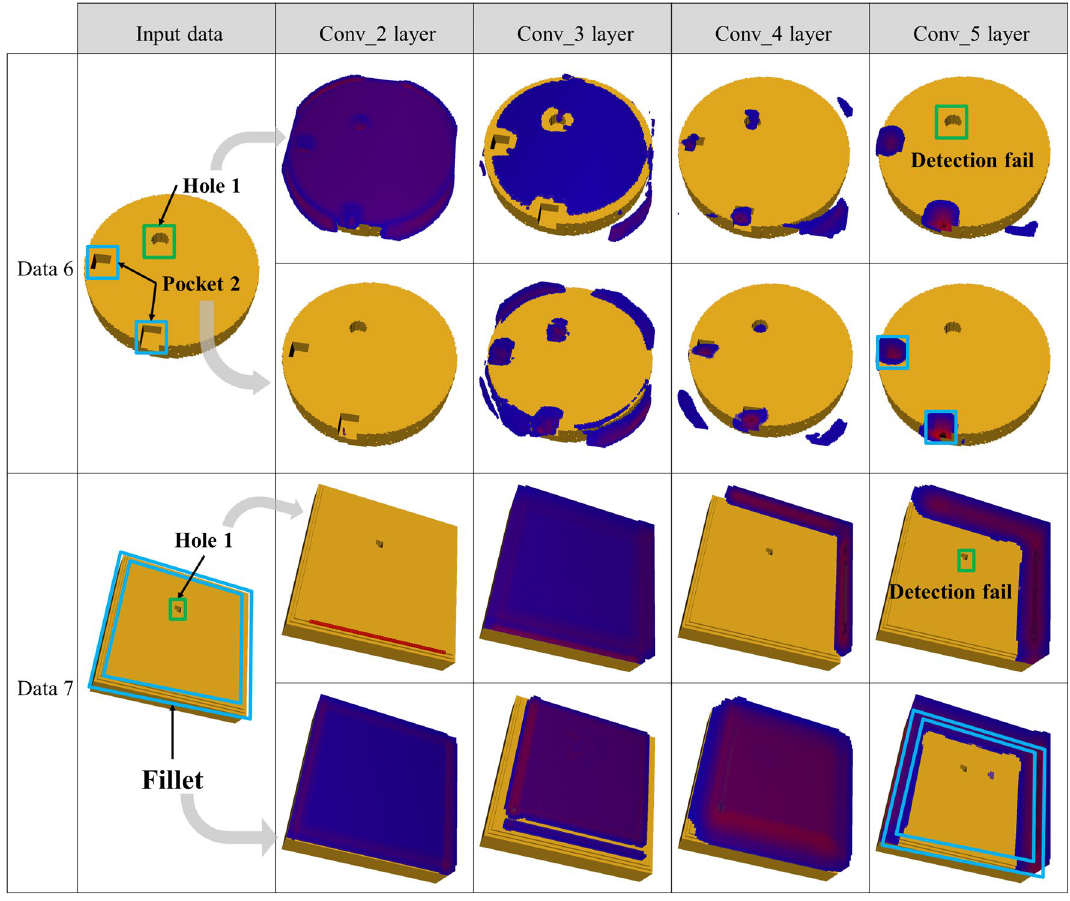
Figure 9. Failure case in feature area